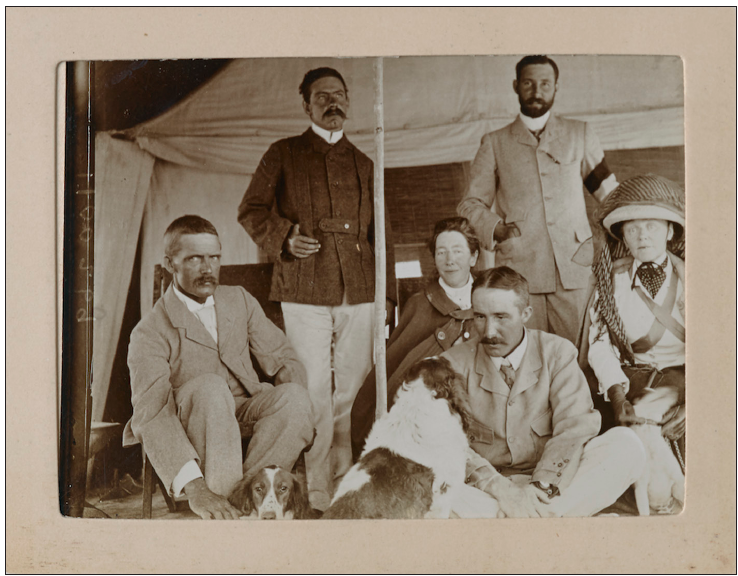
Fig. 3 : At Kabuter Khana: Percy Sykes (back left), Ethel Sykes (centre), and Ellen Tanner (right) with men from the Telegraph Department. Photograph by Herbert Sykes, Sykes Family